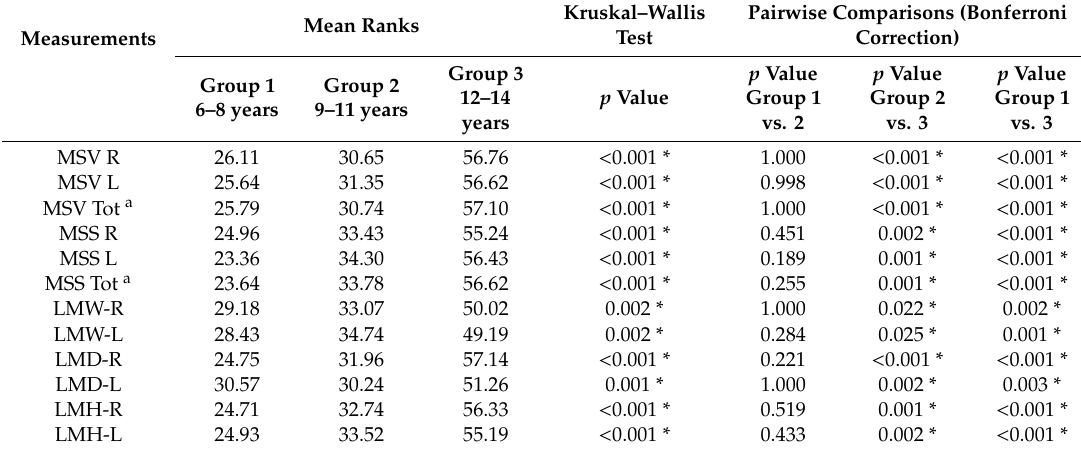
Table 3. Comparisons between groups in male